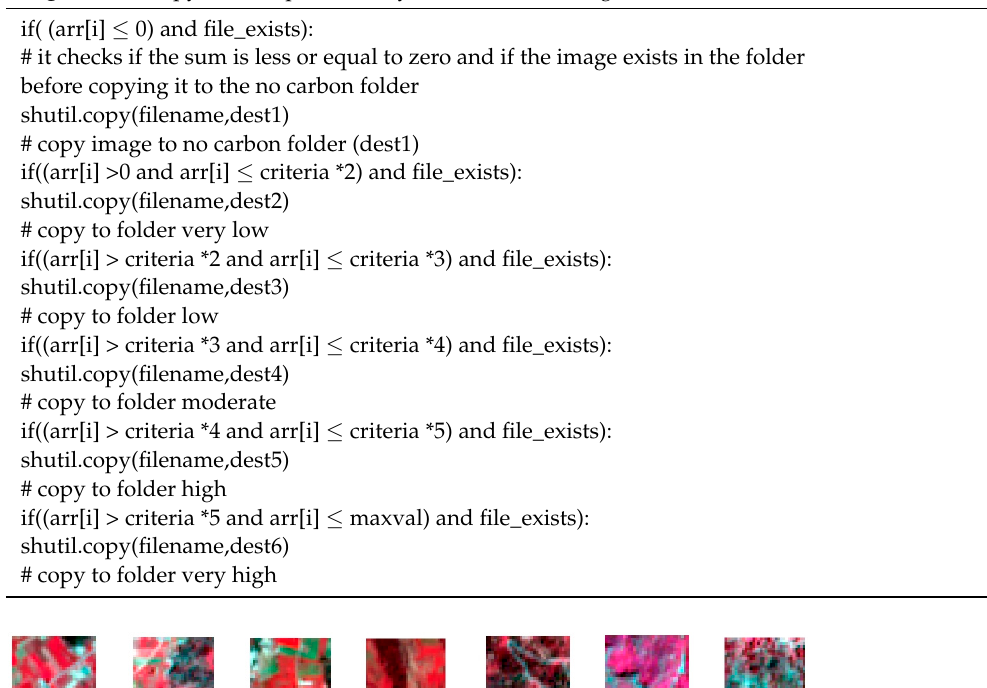
Algorithm 1 A python script to classify Sentinel-2 sub-images.